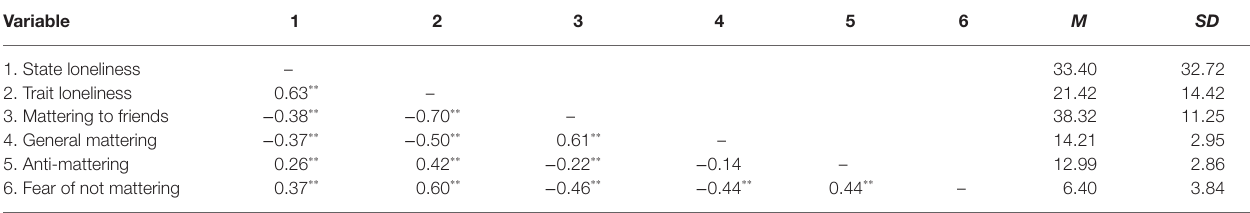
N = 172. Range of possible scores for each construct are as follows: state loneliness: 0–100; trait loneliness: 0–63; mattering to friends; 11–55; general mattering: 5–20; Anti- mattering: 5–20; Fear of not mattering: 0–15. * p < 0.05; ** p < 0.01.